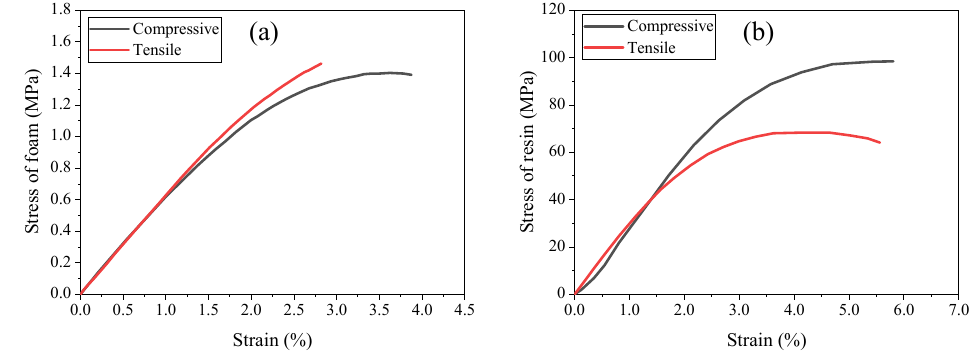
Figure 1. The stress-strain curve of the materials: ( a ) HPE110 foam and ( b ) DQ200E/DQ204H epoxy resin.